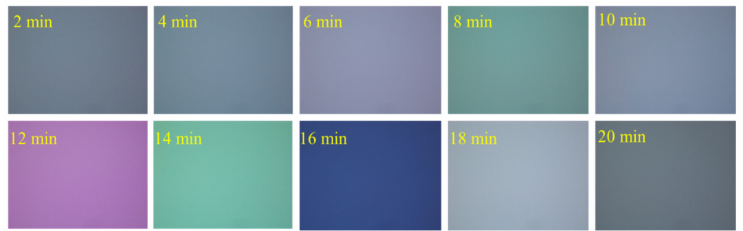
Figure 4. Apparent color of a silica film at different etching time in Buffered Oxide Etch (BOE) solution.